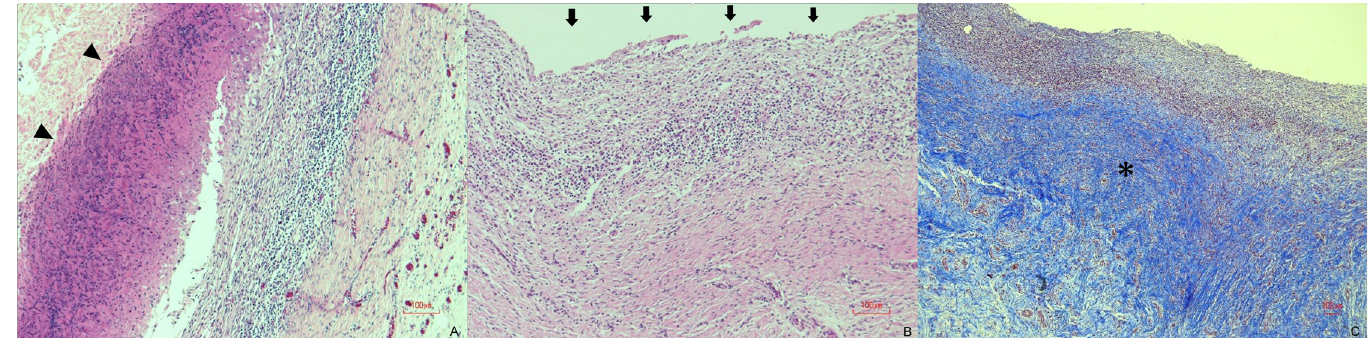
Fig 4. Microscopic examination shows epithelial sloughing (arrow) and necrosis with denaturation (arrowheads) at the site of ablation, which has replaced the granulation tissue and fibrotic changes (asterisk); A , B , hematoxylin & eosin; C , Masson’s trichrome.